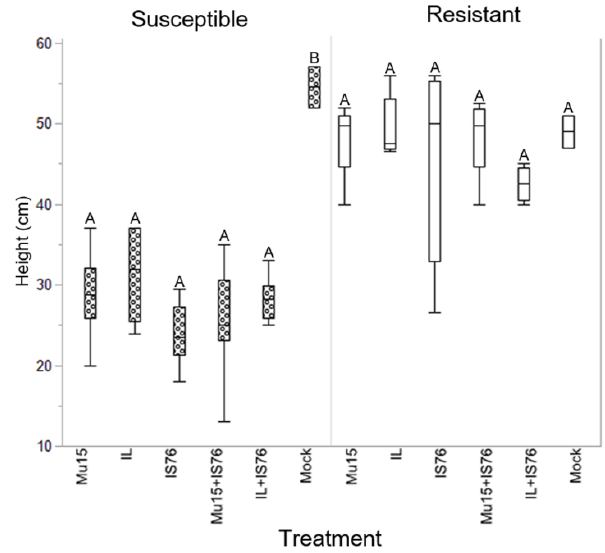
Figure 7. Stem measures (cm) in resistant and susceptible plants at 30 dpi, comparing the effect of the different treatments against control plants inoculated with an empty vector (Mock). Boxplot depicts the median line and delimits the 25 and 75% quantiles. Lines represent the range of values. Capital letters indicate significant differences (Kluskal–Wallis test, p < 0.05) where A represents no significant differences and B represents significant differences. Agroinoculation treatments: single infection, Mu15 (clone TYLCV-Mu15), IL (clone TYLCV-IL), IS76 (clone TYLCV-IS76), and mixed infections Mu15 + IS76 (a mixture of TYLCV-Mu15 and TYLCV-IS76) and IL + IS76 (a mixture of TYLCV-IL and TYLCV-IS76).